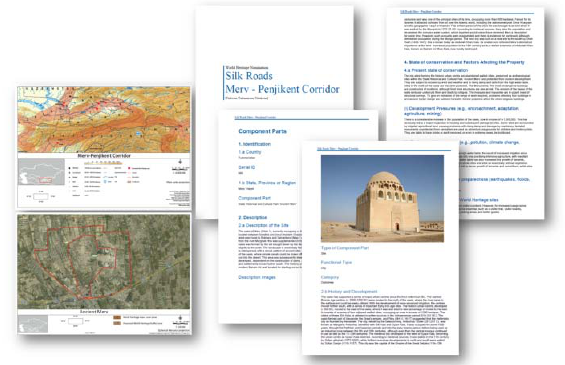
Table 2: Example of used Landsat ETM+ imagery.